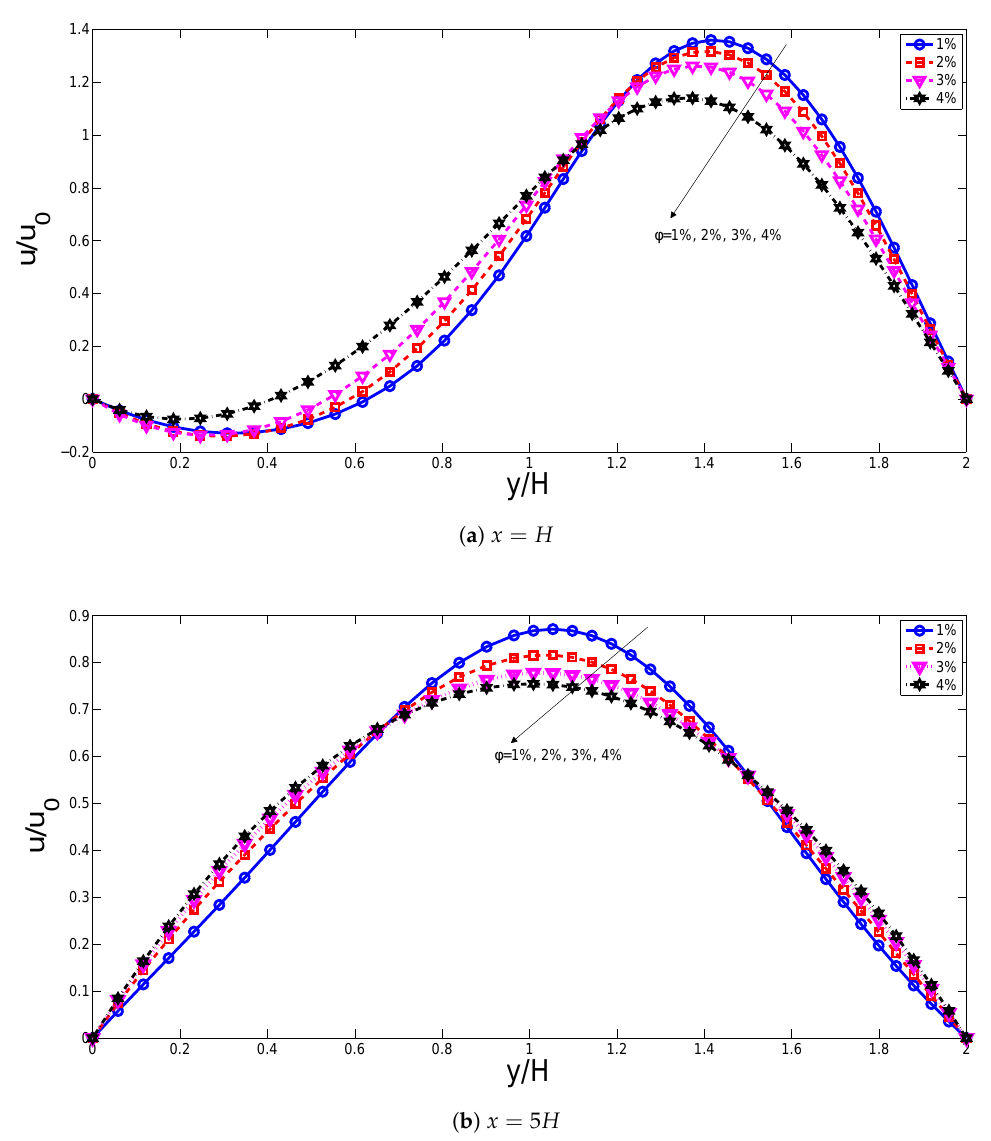
Figure 4. Variation of the x component velocity along the y direction for various nanoparticle volume fractions with cylindrically-shape